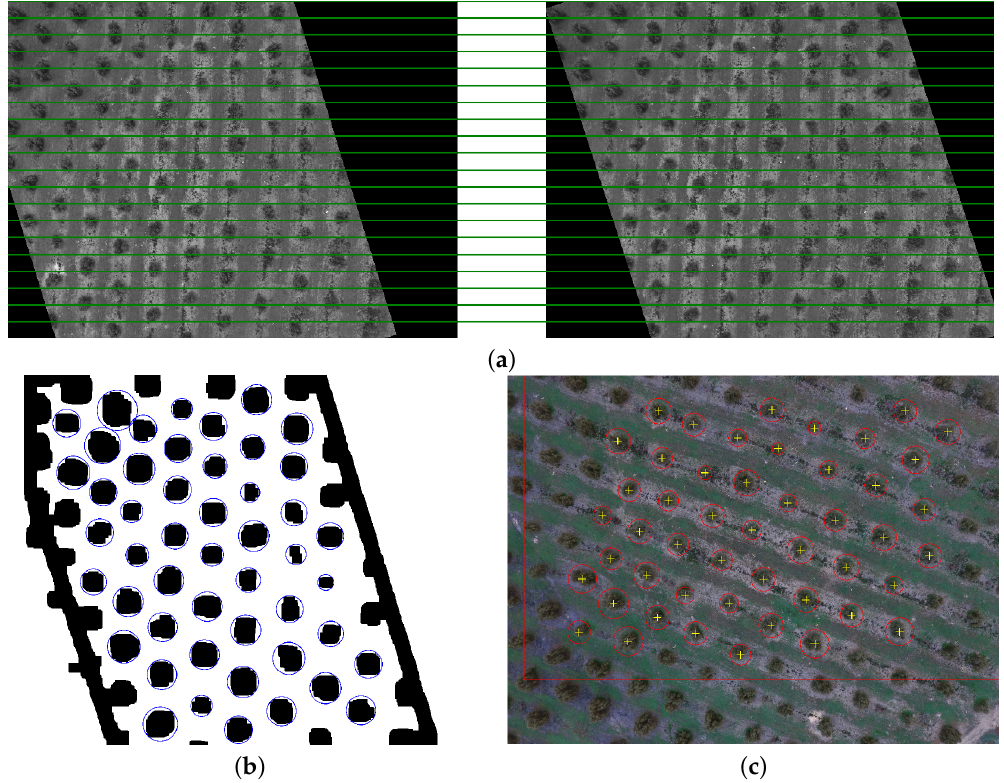
Figure 6. Images corresponding to the intermediate steps when applying the stereo vision-based segmentation algorithm to the image DJI_0225. ( a ) Rectified images using epipolar geometry (epipolar lines are shown in green). ( b ) Adaptive threshold on the disparity matrix. ( c ) Detected trees. Image rectification is the process of projecting two images of the same scene on a common